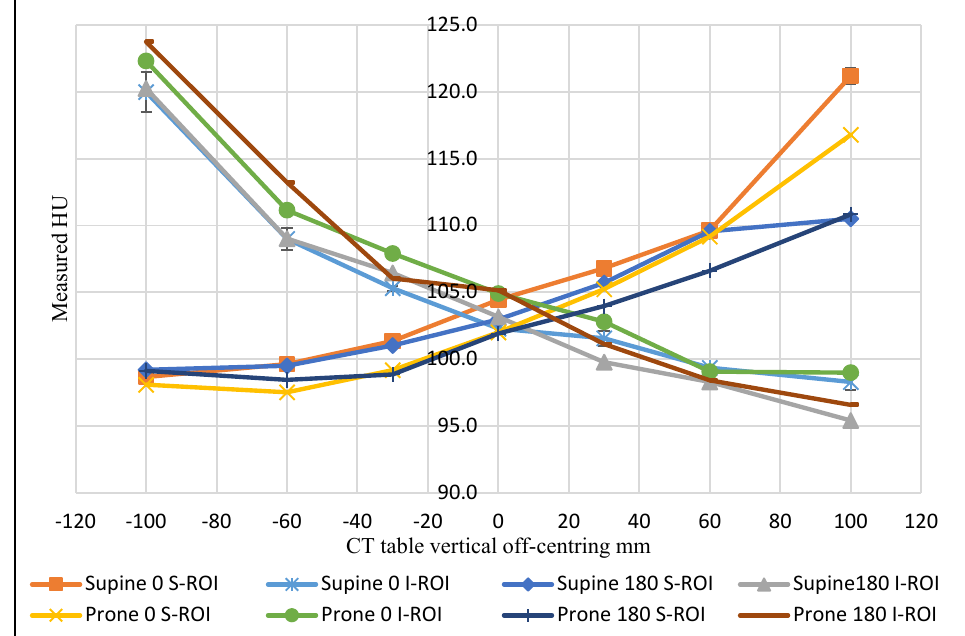
Figure 2. The CT number change as a function of CT table vertical off-centring for the superior and inferior ROIs for the abdominal section at 120